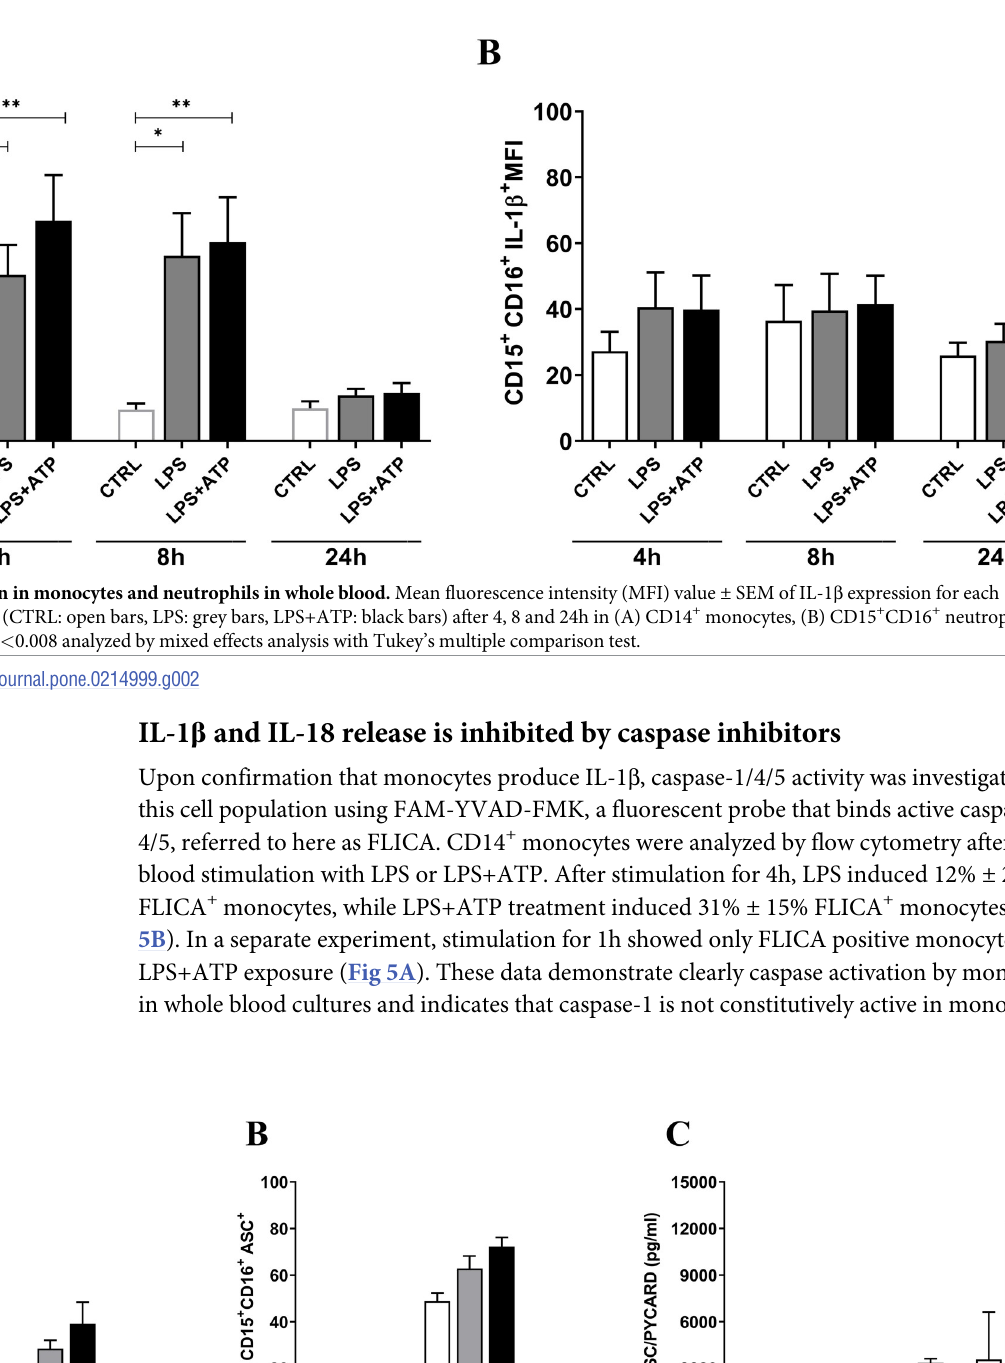
PLOS ONE | https://doi.org/10.1371/journal.pone.0214999 April 8,